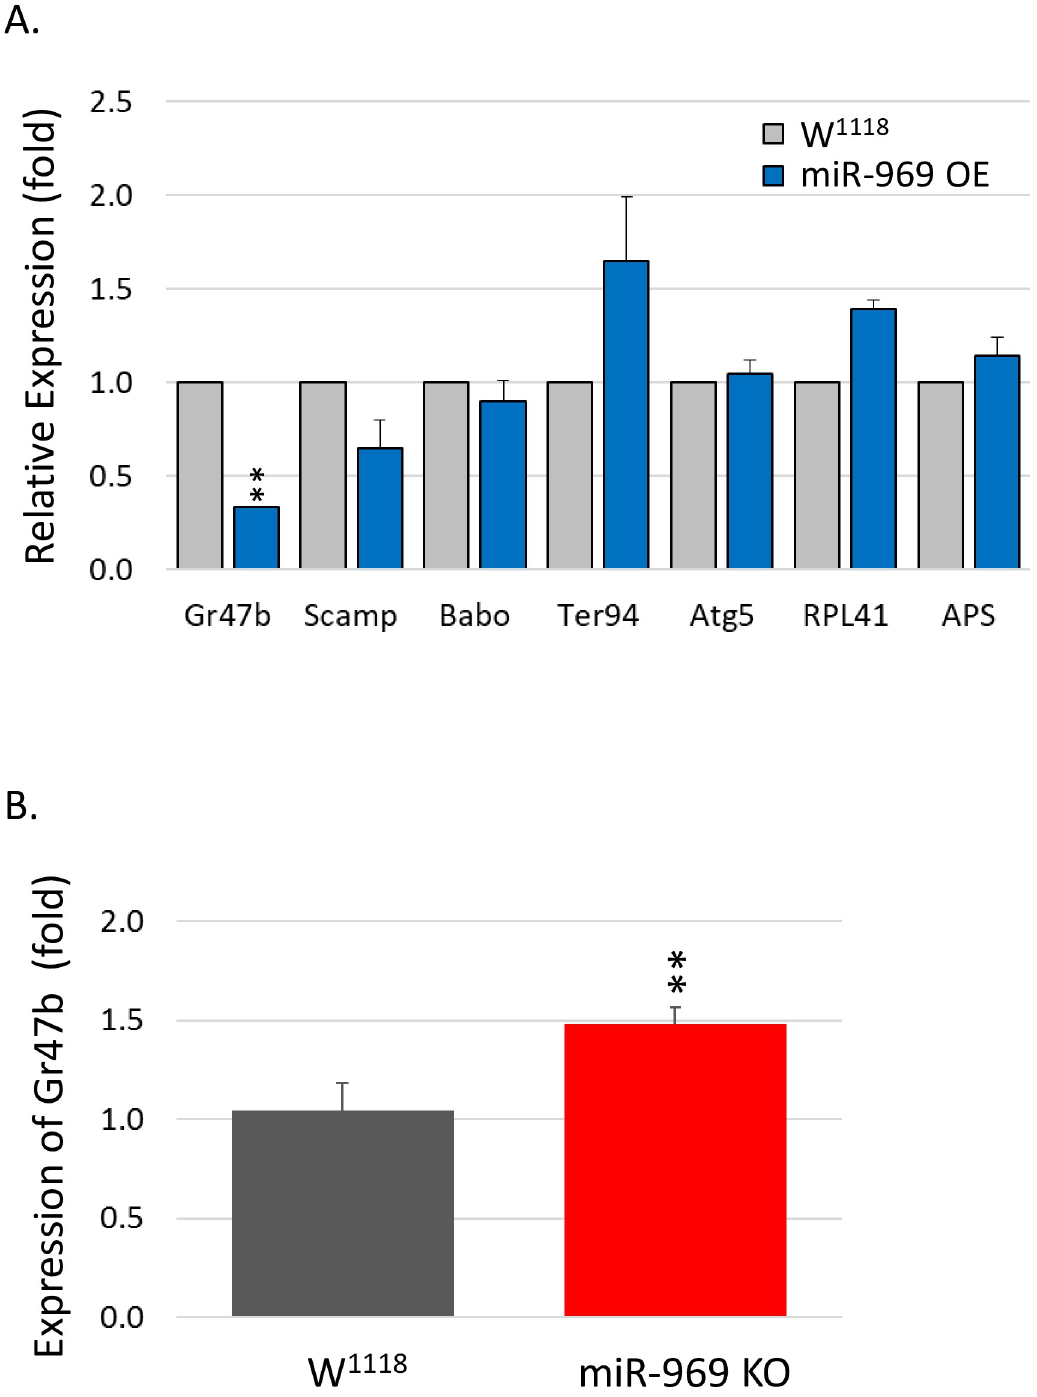
Fig 5. Altered expression of possible target genes of miR-969. (A) Overexpression of miR-969 reduced Gr47b expression. The miR-969 overexpression line was generated by crossing the UAS-miR-969 with the Act5C-Gal4 driver. Total RNA was extracted from the resulting F1 adults and converted to cDNA for qPCR analysis. The expression levels of the seven candidate genes were determined, and they were Gustatory receptor 47b (Gr47b), Secretory carrier membrane protein (Scamp), Activin receptor Baboon (Babo), Transitional endoplasmic reticulum ATPase (Ter94), Autophagy protein 5 (Atg5), Ribosomal protein L41 (RPL41), and Nudt3 Drosophila homolog (APS). (B) MiR-969 knock-out line increased Gr47b expression compared to the W 1118 control. Gr47b expression was determined by qPCR. Statistical analysis was performed by Student’s T-test. � : P < 0.01.